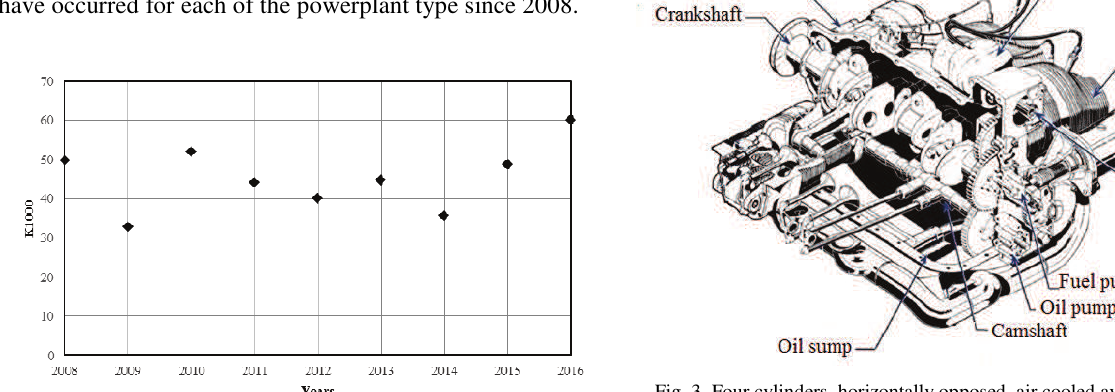
Fig. 3. Four cylinders, horizontally opposed, air cooled aviation piston engine